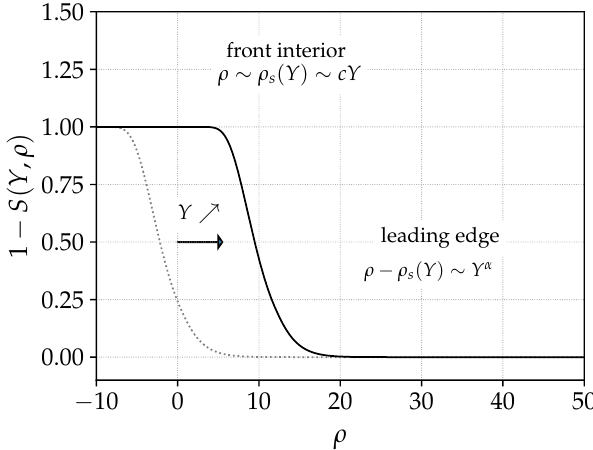
Figure 5. Illustration of the traveling wave and its front propagation. The front propagates from the left to the right as Y increases. The domains studied analytically in this paper are represented: the interior of the front, corresponding to ρ − ρ s ( Y ) (cid:28) Y α , where the non-linearities become important, and the leading edge regime with ρ − ρ ( Y ) ∼ Y α . In the fixed coupling evolution, α = 1 / 2 while for the running coupling one, α = 1 / 6